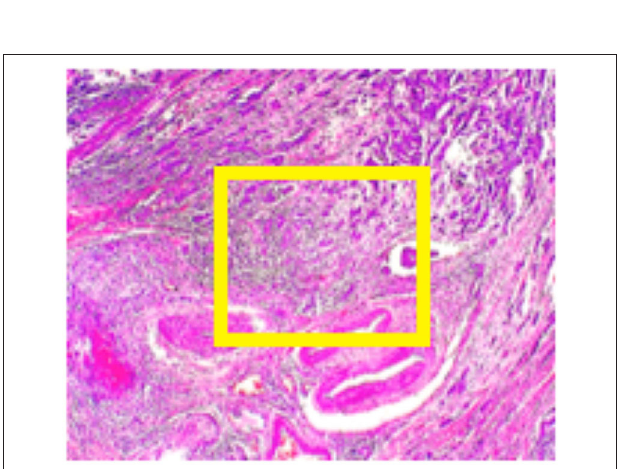
FIGURE 2 | BreakHis sample at 40x magnification for a malignant segment tissue with a yellow bounding box indicating the approximate location of the malignant tissue (for visualization purposes) surrounded by healthy